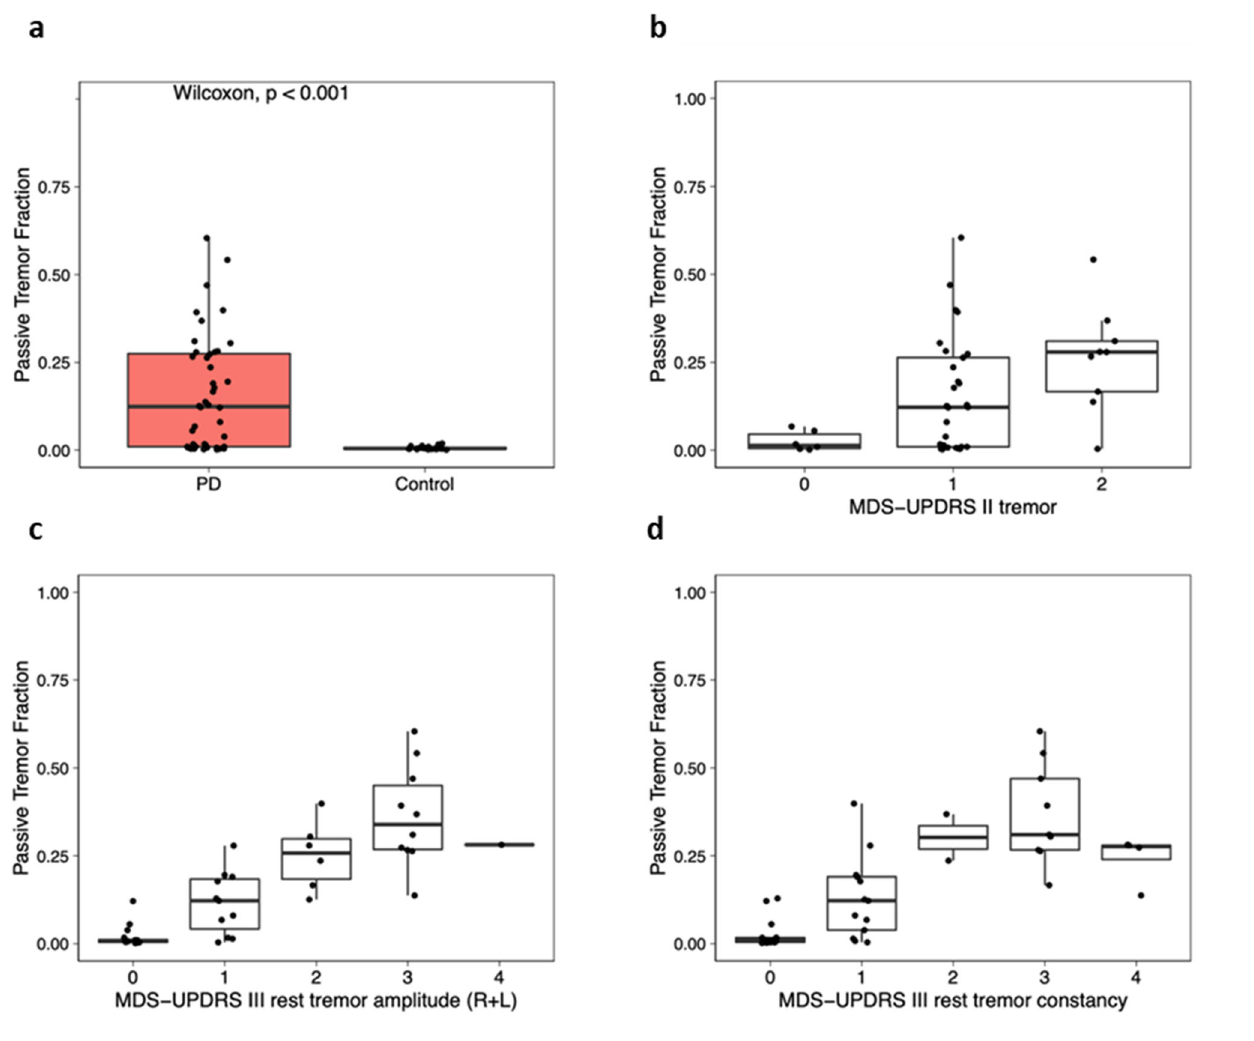
Fig. 3 Comparisons of tremor scores derived from continuous passive tremor data from a smartwatch. Box plots for passive tremor fraction between (panel a ) those with and without Parkinson ’ s disease and by (panel b ) MDS-UPDRS part II tremor, (panel c ) MDS-UPDRS part III rest tremor amplitude (right + left), and (panel d ) MDS-UPDRS part III rest tremor constancy. MDS-UPDRS Movement Disorder Society- Uni fi ed Parkinson ’ s Disease Rating